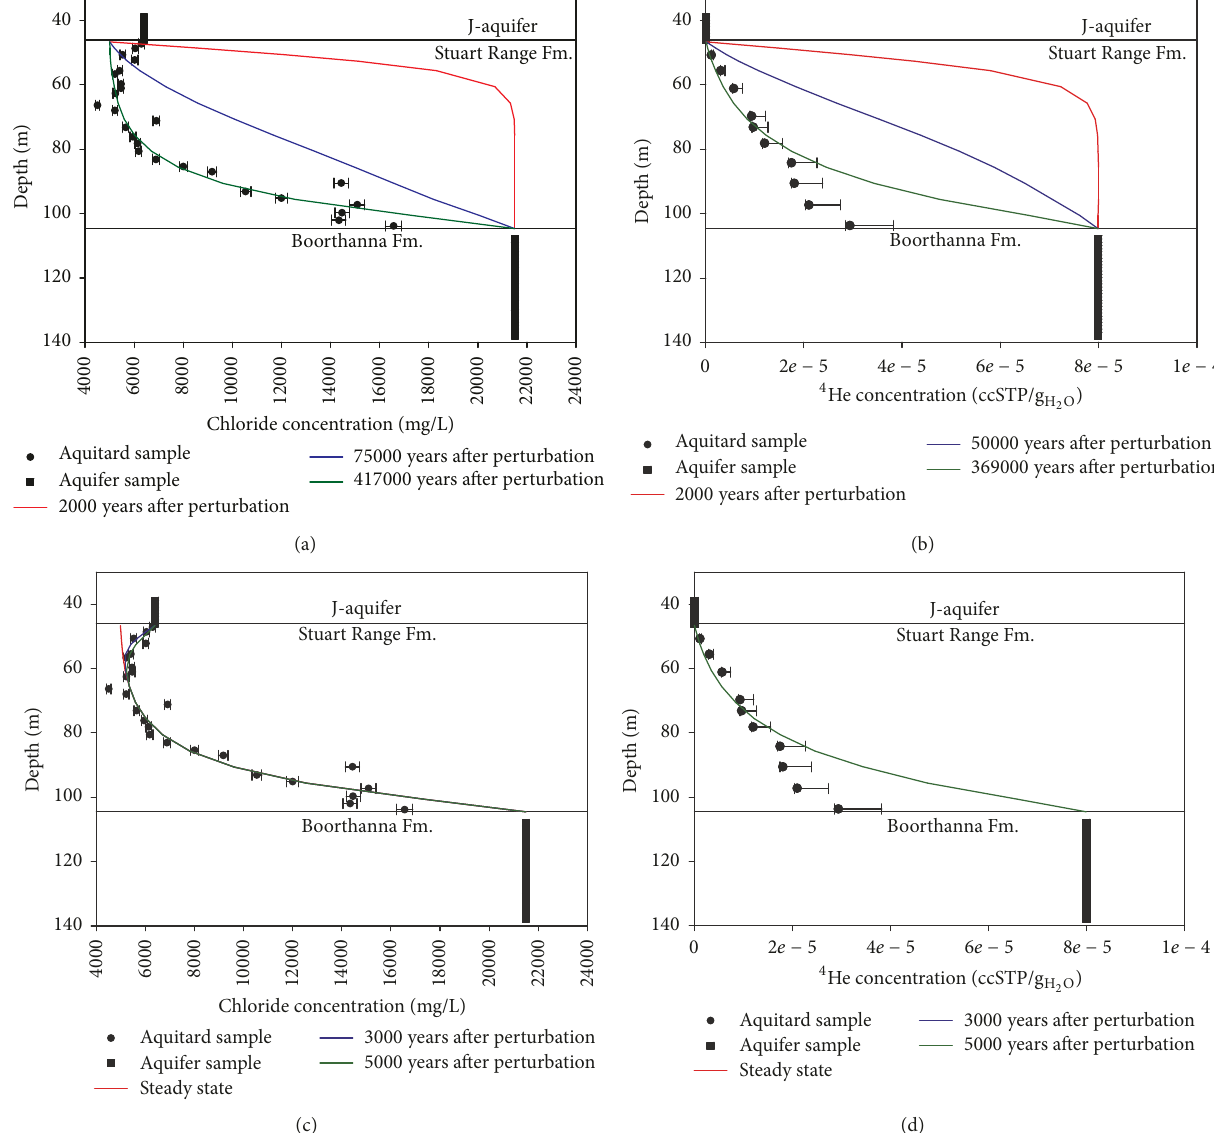
Figure 5: Time taken to reach steady state solute transport in model 4 from continuous high concentrations throughout the profile for (a) chloride and (b) 4 He concentration; the chloride concentration was then increased in the upper aquifer in model 5 giving the profiles for (c) chloride and (d) 4 He